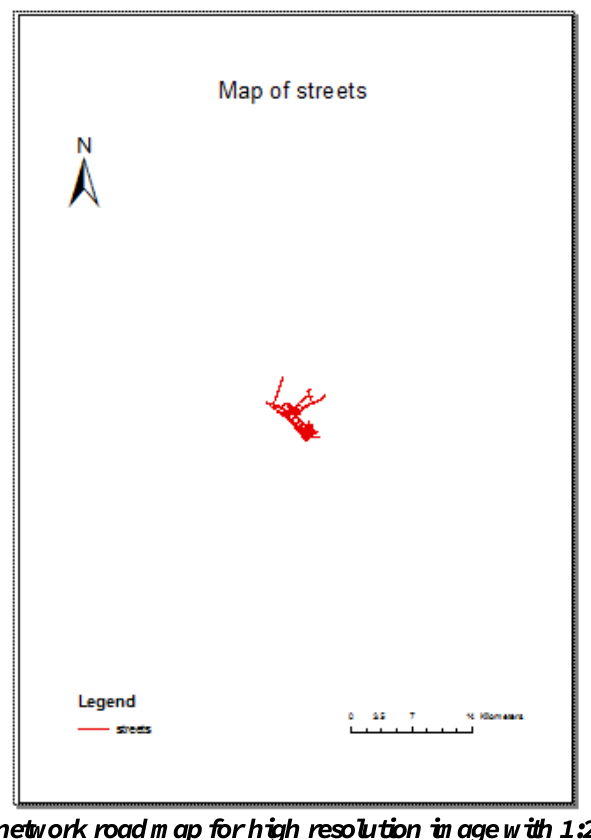
Fig.16: The network road map for high resolution image with 1:250,000 scale.